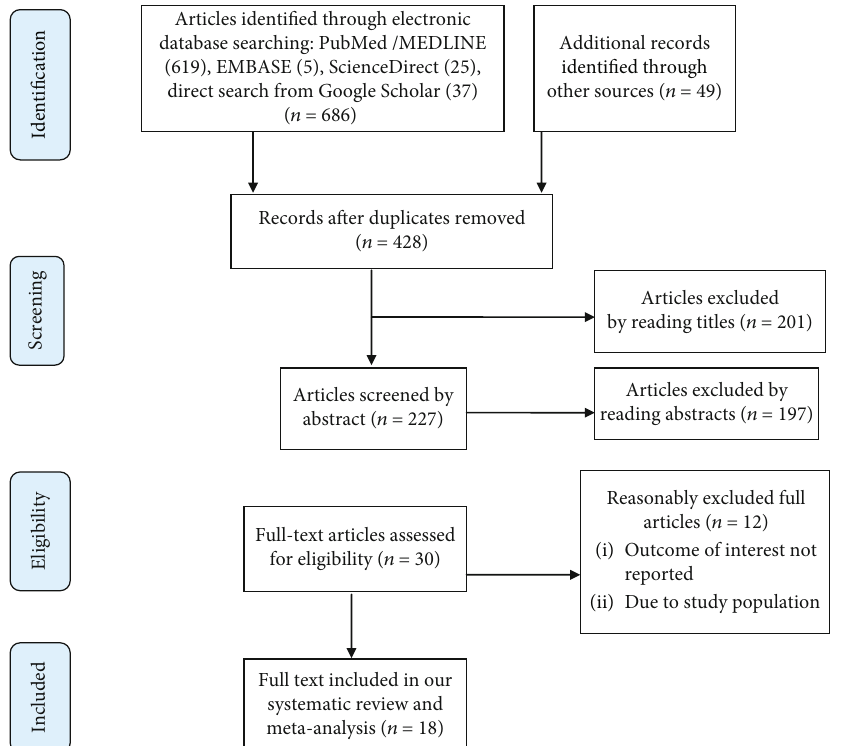
Figure 1: Flow chart describing the selection of studies for the systematic review and meta-analysis of prevalence and determinants of postpartum contraceptive use among mothers in Ethiopia,